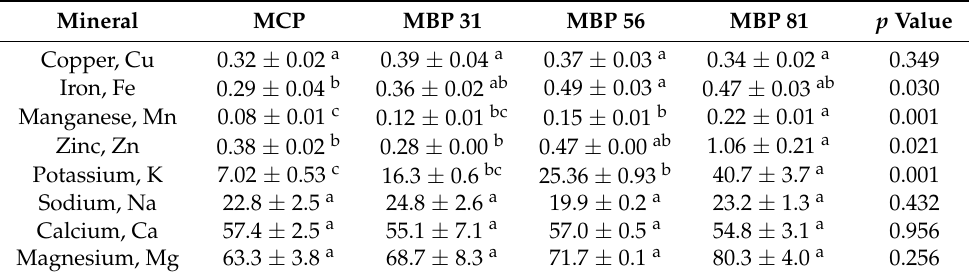
Table 4. Mineral composition of formulated maize porridges (mg/100 g wt). The results are expressed as mean ± SD. Different lower-case letters represent statistical differences.